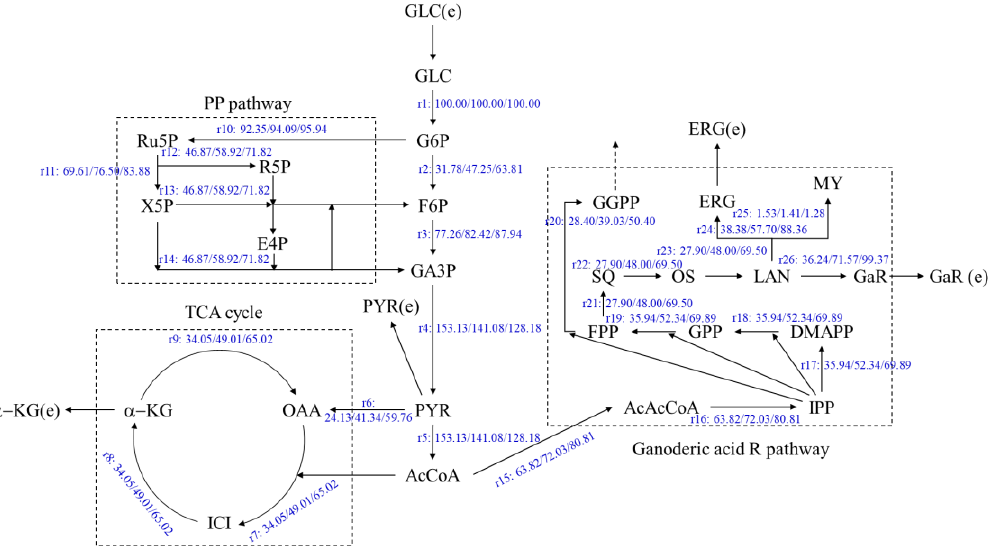
Figure 3. Metabolic flux distribution of ganoderic acid R, synthesized by submerged fermentation- static culture under two methods of oleic acid addition. Left: Control (the 10th day of static culture); Middle: Filter-sterilized oleic acid (15th day of static culture); Right: High-temperature-sterilized oleic acid (10th day of static culture).